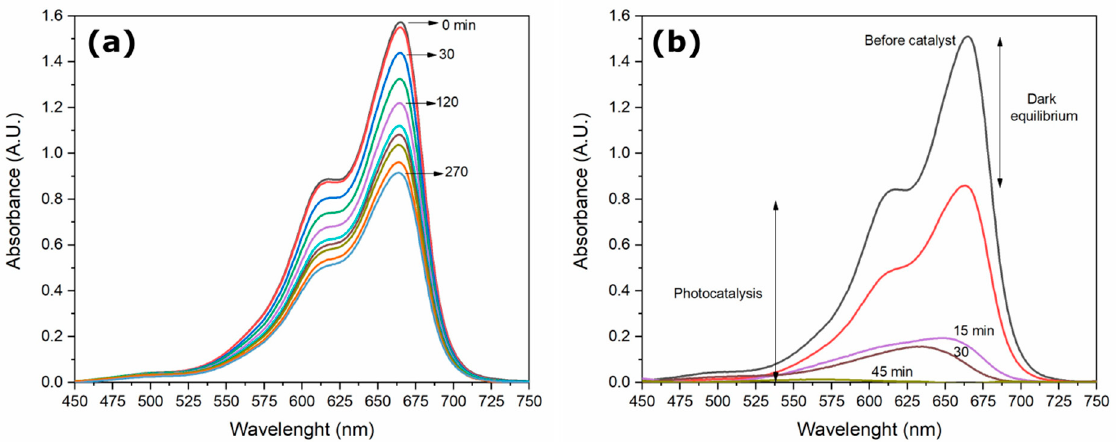
Figure 8. Absorbance spectra of MB: ( a ) no catalyst at 270 min and ( b ) ZnO- Tagetes erecta at 45 min.